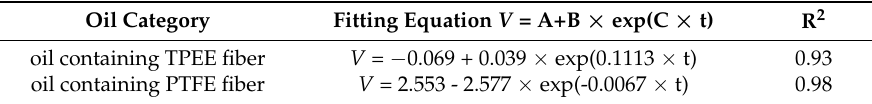
Figure 5. Acid of oil curve. Table 2. Fitting relations between the acid values and aging time.